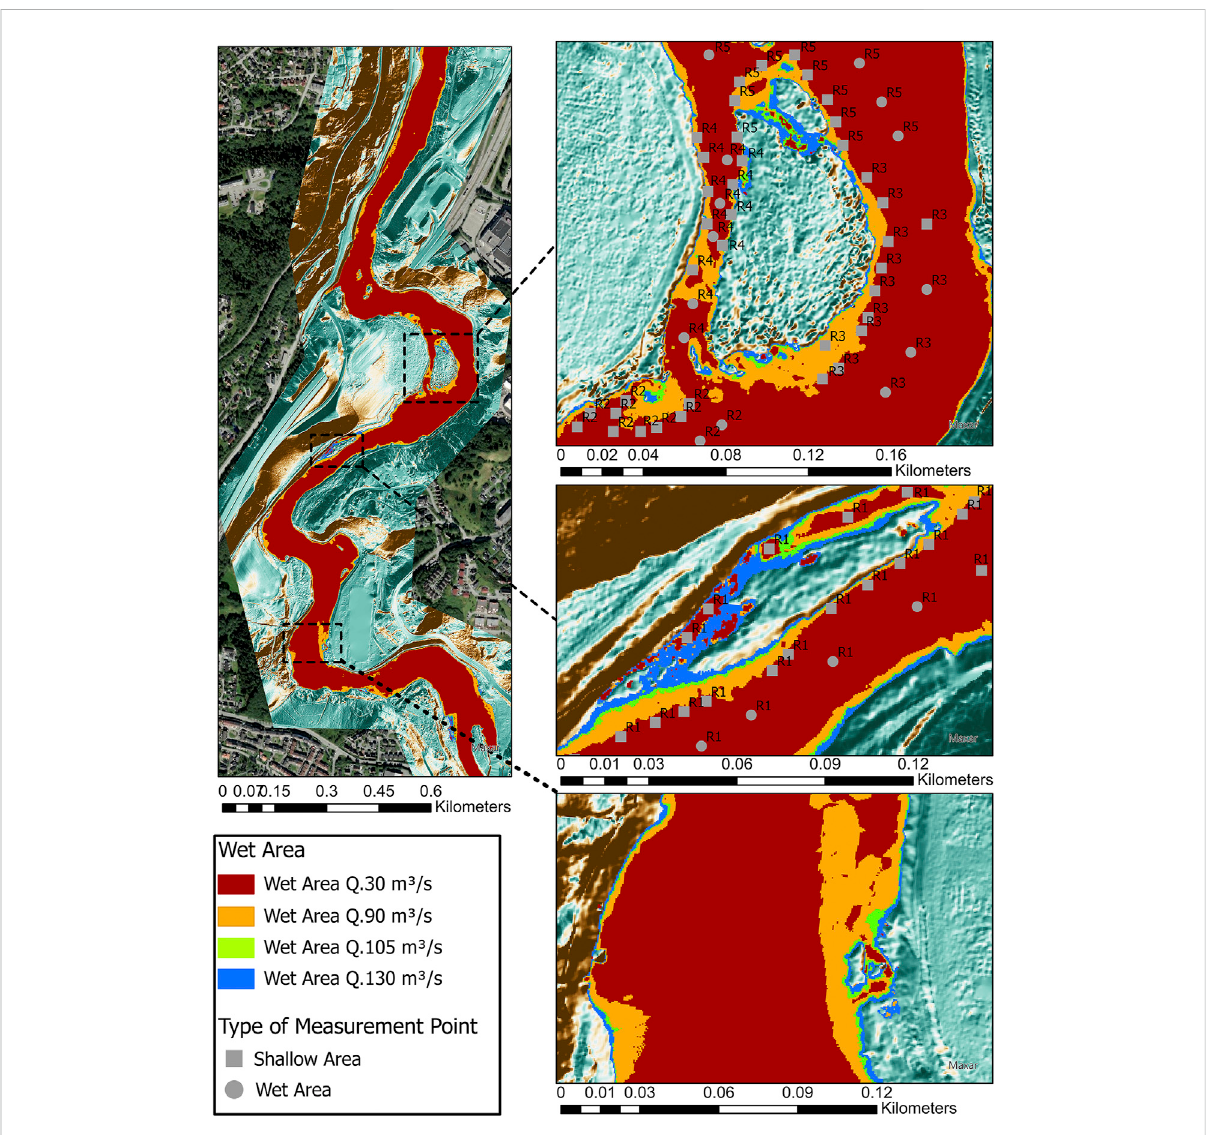
FIGURE 2 Sites where dewatering was computed for mitigation analysis. Regions 1 – 5 are shown on the map as R1 – R5 and locations for the extraction of dewatering curves are marked with a round symbol for permanent wet areas and a square symbol for areas that dried out during down ramping. Upper leftpanel: an overview of thesitesusedfor dewateringcomputations; upperrightpanel:Trekantensite (regions2 – 5);middlerightpanel: side channel site (region 1); lower right panel: Stryket site. Adapted from Kenawi